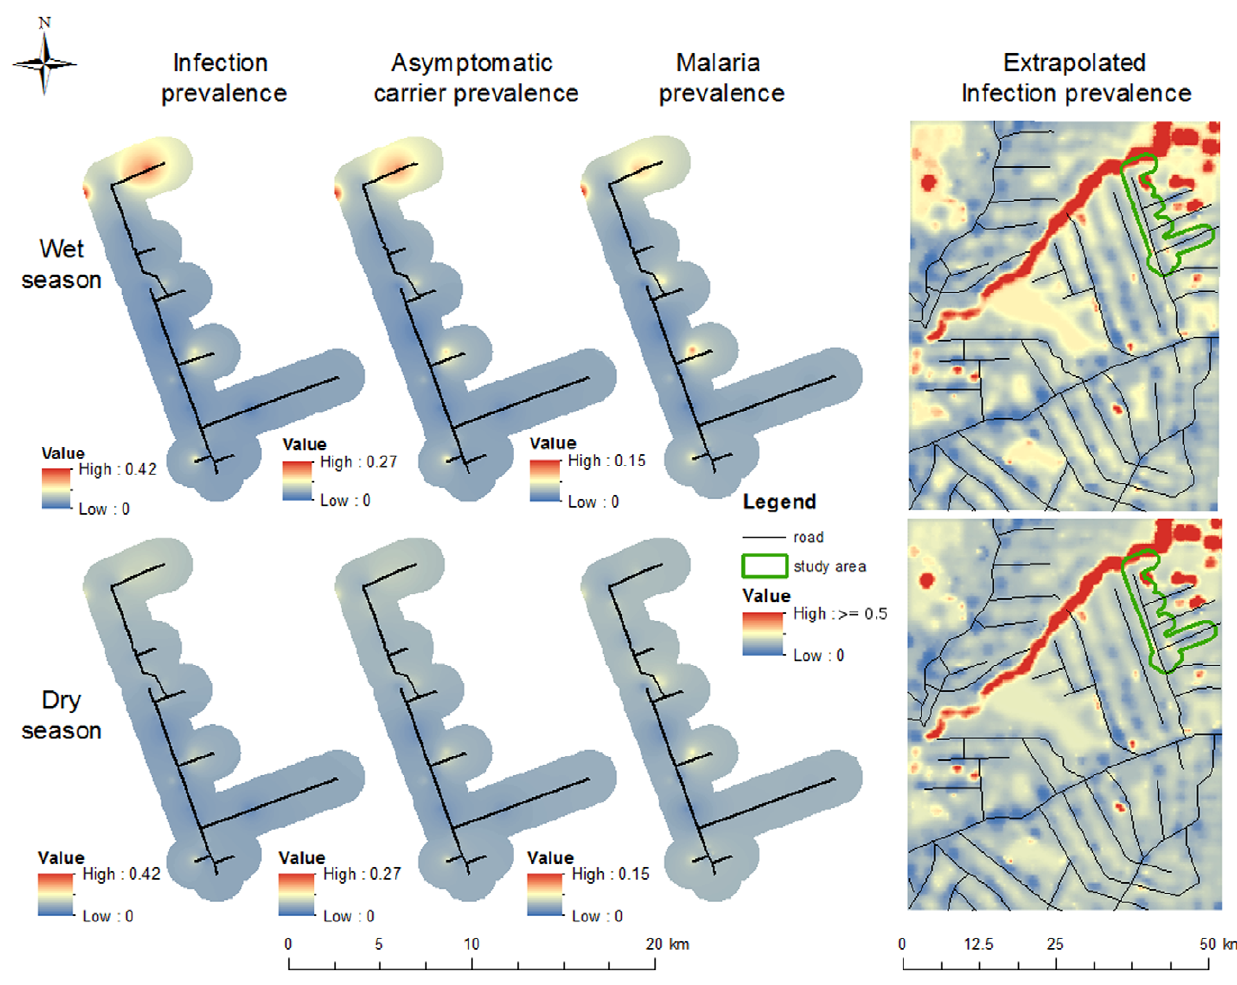
Figure 7. Spatial distribution of infection, asymptomatic carrier, and malaria prevalences. From left to right, maps depict interpolated surfaces of predicted infection prevalence (i.e., p I ~ 1 ð Þ ), asymptomatic carrier prevalence (i.e., p S ~ 0, I ~ 1 ð Þ )), and malaria prevalence (i.e., p S ~ 1, I ~ 1 ð Þ ), all for the studied area, and an extrapolated surface of infection prevalence. Upper and lower maps are the prevalence surfaces for the rainy and dry seasons, respectively. Interpolation was done using an inverse distance weighted